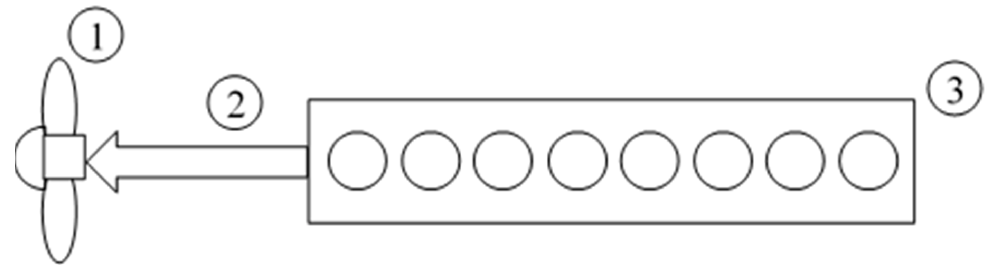
Figure 3. Propulsion with a low-speed diesel engine and direct drive (Legend: 1—propeller, 2—propeller shaft, 3—two-stroke diesel engine).